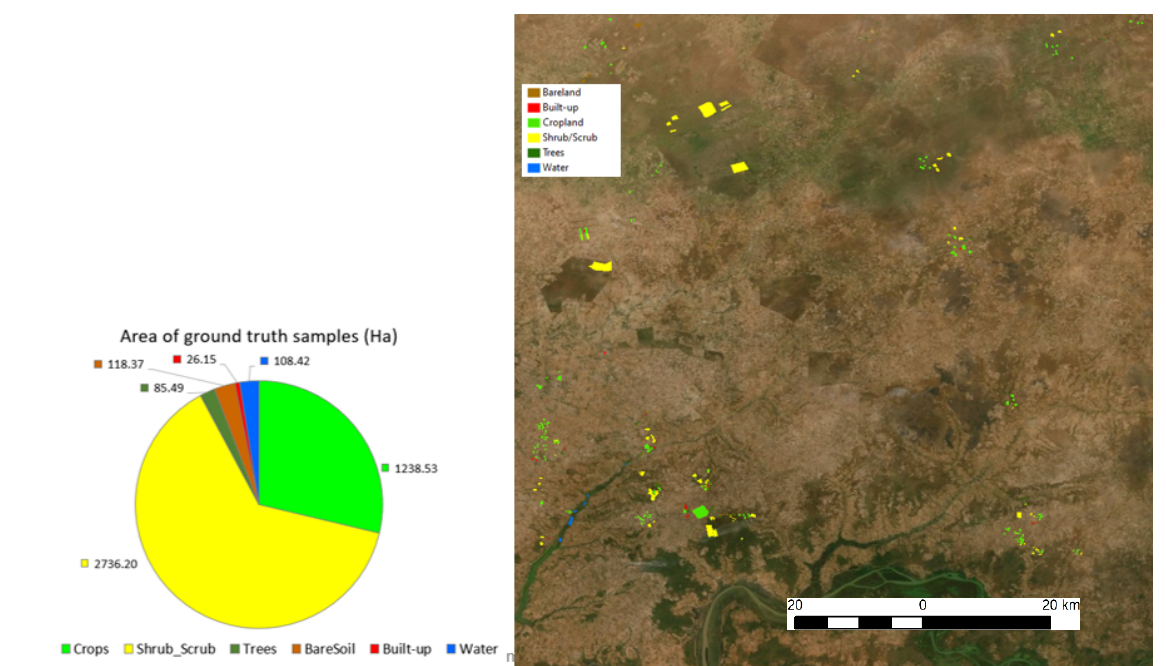
Figure 3. The ground truth data collected. The samples were not balanced, with 123,850 pixels (1238.5 ha) of crops, 273,600 pixels (27,360 ha) of shrubs/scrubs, 8540 pixels (85.4 ha) of trees, 11,840 pixels (118.4 ha) of bare soil, 2610 pixels (26.1 ha) of built-up area, and 10,840 pixels (108.4 ha) of water. From each class, we used 40% of the pixels for training the classifiers, and the remaining 60% were used for validation.